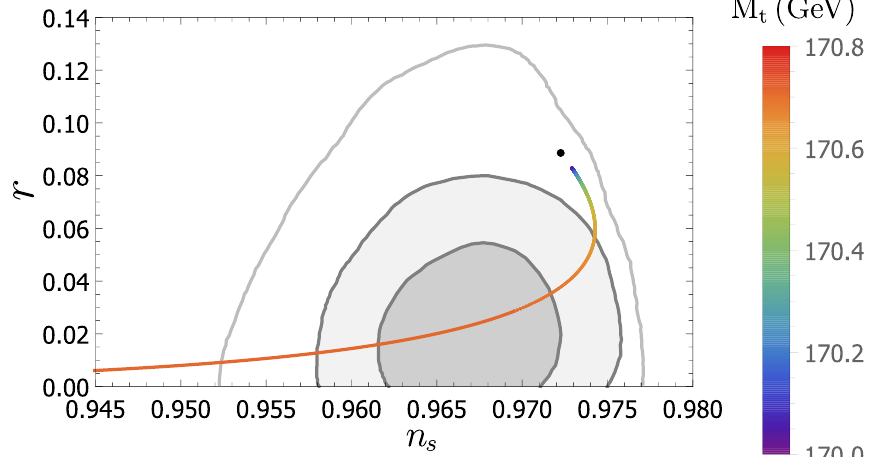
(a) In(cid:13)ationary predictions for varying top mass. The black dot represents the tree level result that is reached for unrealistic values M t < 160 GeV.